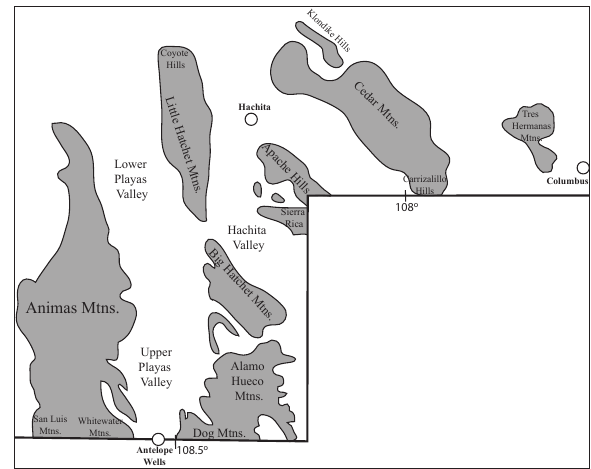
Fig. 2. Physiographic map of southwestern New